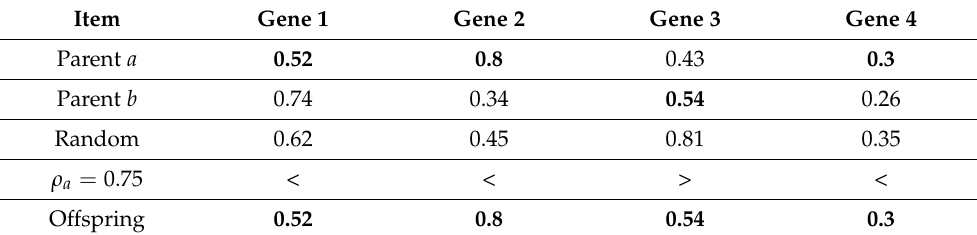
Table 1. Example of a crossover of two parents a and b using the coin tossing method. Individuals have 4-gene chromosomes. After generating 4 random numbers (one per each gene), the obtained values are compared to ρ a . Item Gene 1 Gene 2 Gene 3 Gene 4 Parent a 0.52 0.8